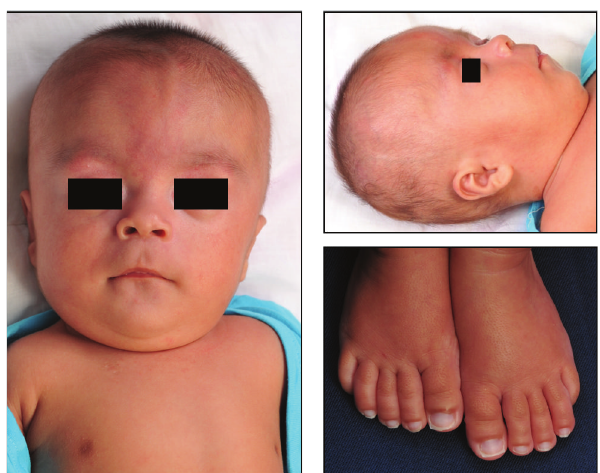
Figure 1: Frontal and lateral views of the face along with the feet showing long toes and square nails at the age of 4